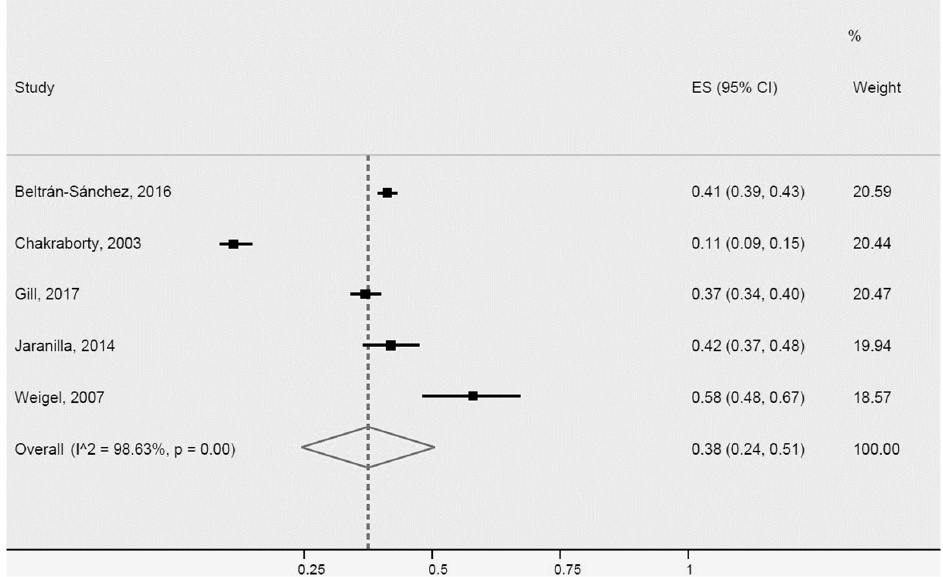
Figure 10. High triglycerides for Latinos in the US. ES = Estimated proportion/prevalence; CI = Confidence interval; I^2 = I 2 index.